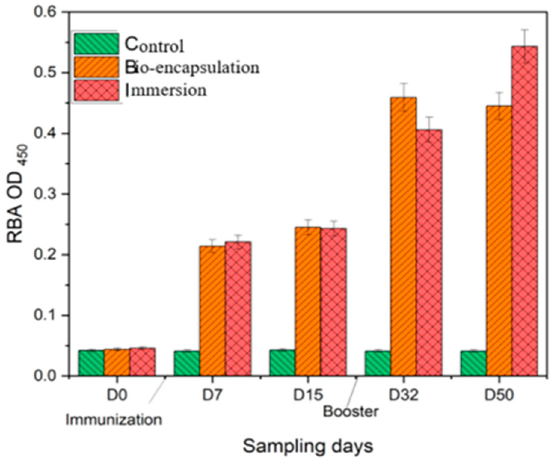
Figure 6. Respiratory Burst Activity of the juvenile Cyprinus carpio L. in all three groups, control, bio-encapsulated and immersion at day 0, 7, 15, 32 and 50.